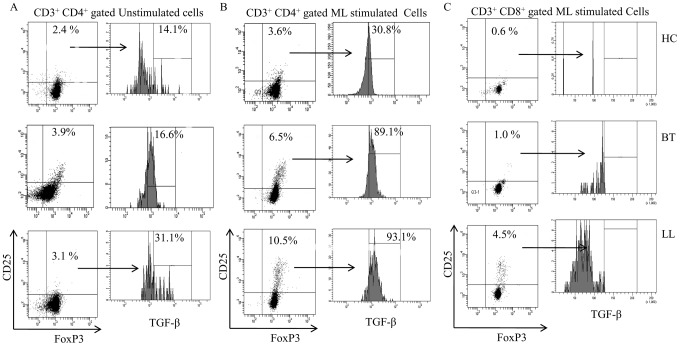
Flow cytometry analysis of PBMC cultures from representative leprosy patients and healthy subjects for FOXP3 and intracellular TGFβ.Unstimulated basal PBMC cultures (A) of lepromatous patients showed higher percentage of CD25+FOXP3+ T regs as compared to other clinical groups. M. leprae stimulated cultures (B) showed further increase in this population in lepromatous leprosy patients as compared to tuberculoid and healthy contacts. Increased percentage of TGF-β+ cells was observed in the Tregs of lepromatous as compared to other clinical groups in the basal unstimulated and antigen stimulated PBMC. CD8+ lineage of T cells (C) also showed increase in FOXP3 positivity in lepromatous leprosy. However, TGF-β was not detectable in these cells. Abbreviations and p values as in legend to Figure 2. iTreg: in vitro derived peripheral blood T cells with Treg signature markers of CD25 and FOXP3. Abbreviations as in Figure 2.